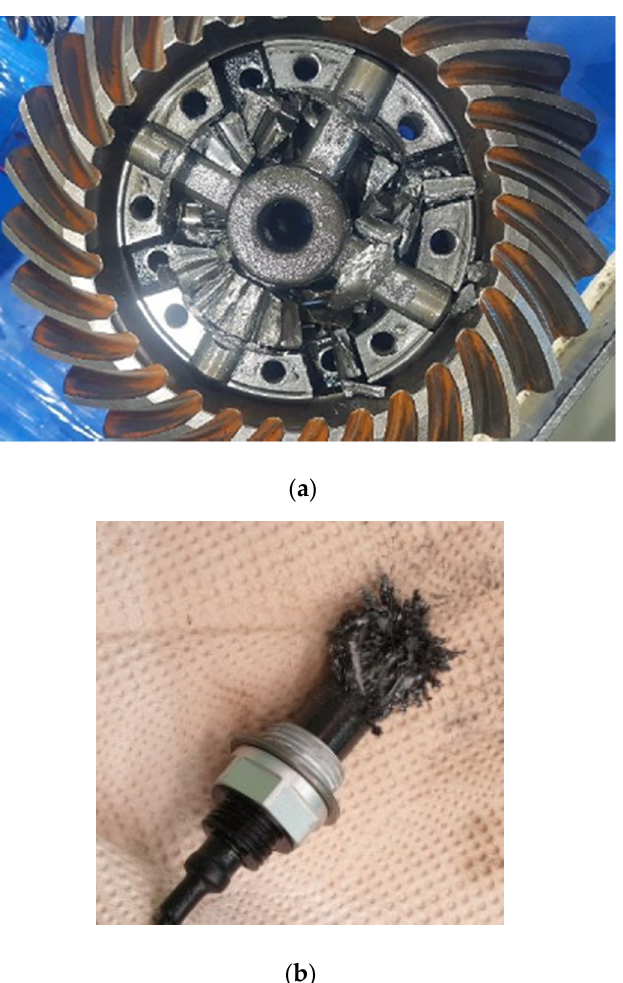
Figure 11. Broken axle and ferrous wear particles: ( a ) Gear breakage at the axle; ( b ) Ferrous wear particles attached to the sensor.